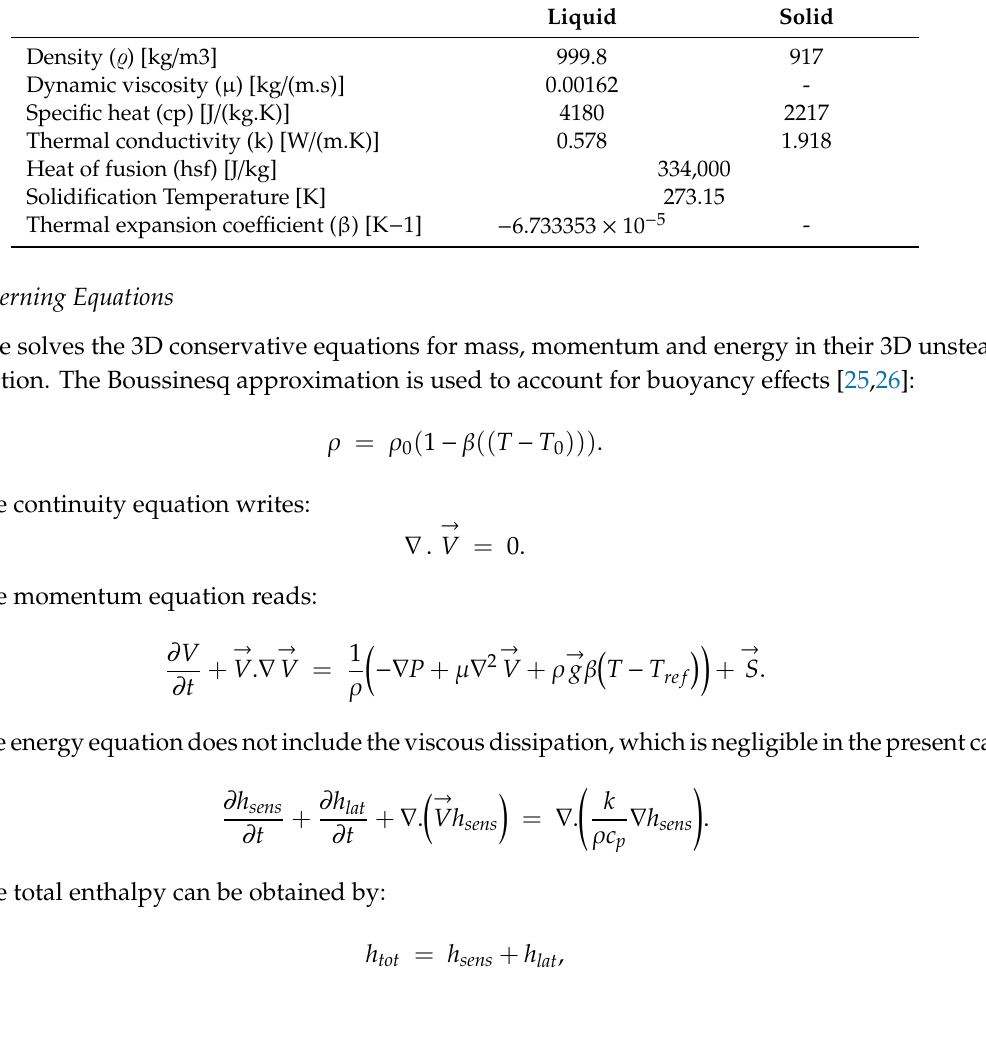
Figure 2. Three types of tubes considered in the present paper: ( a ) U-shaped tube, ( b ) coil tube model 1, and ( c ) coil tube model 2. Table 1. Physical and thermal properties of liquid and solid water [9,24]. Pure Water Property